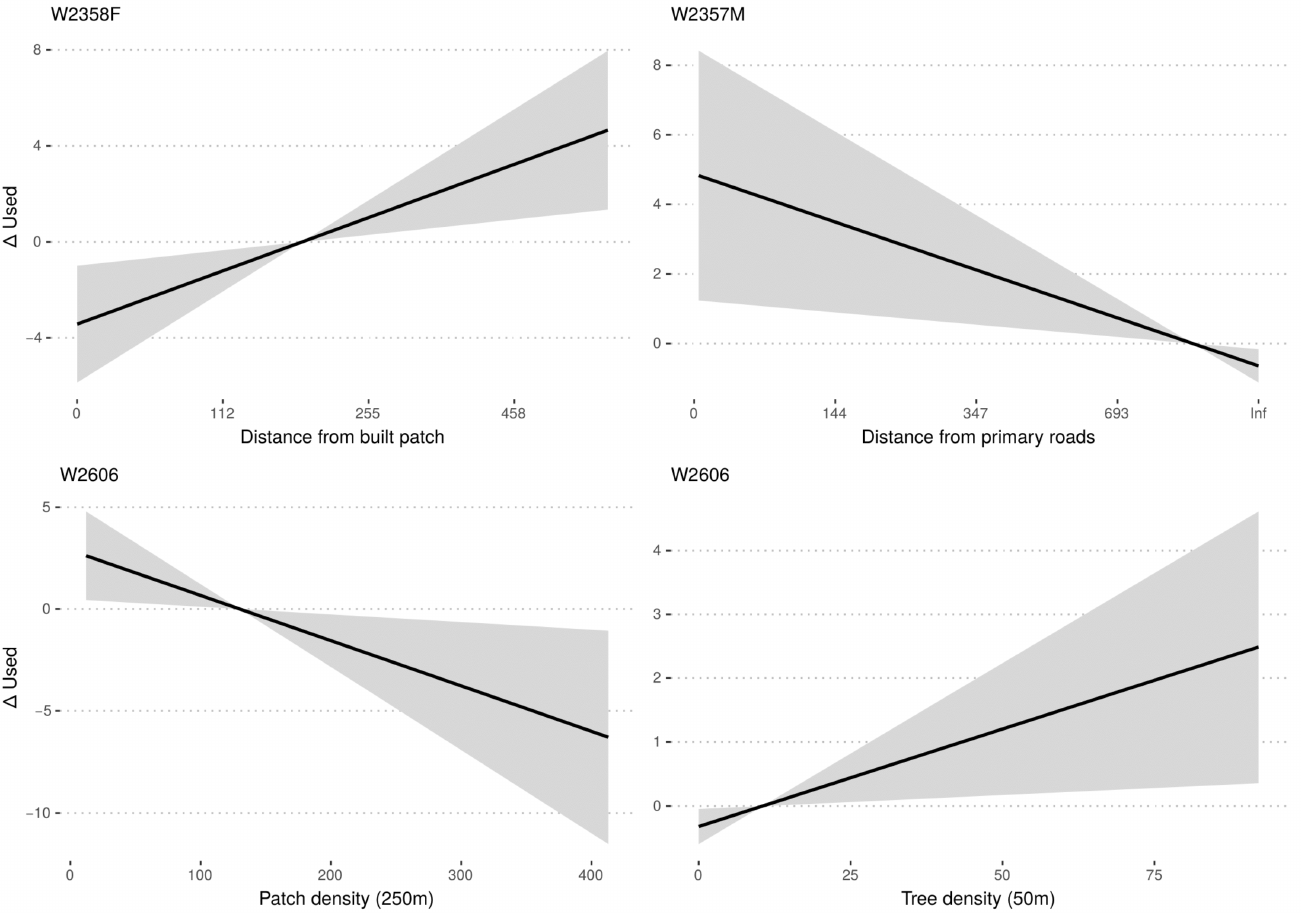
Figure 5. The fitted regression lines with standard error showing the statistically significant environ- mental predictor that drives individual selection of resting sites, as estimated by conditional logistic